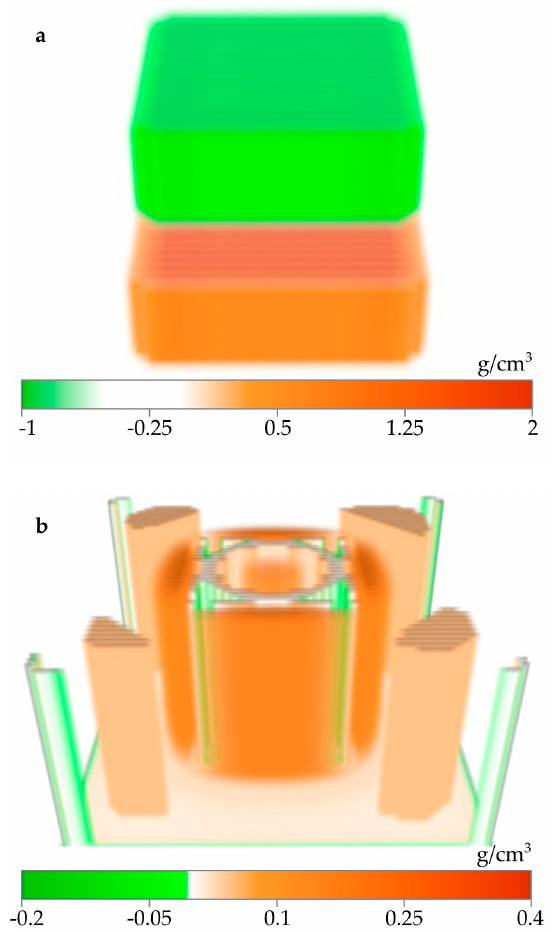
Figure 5. Linear inverse problem solution ( a ) with a 𝜌 (cid:2868) (𝑧) dependence for the initial model (Figure 4) and ( b ) with 𝜌 (cid:2868) (𝑧) ≡ 1